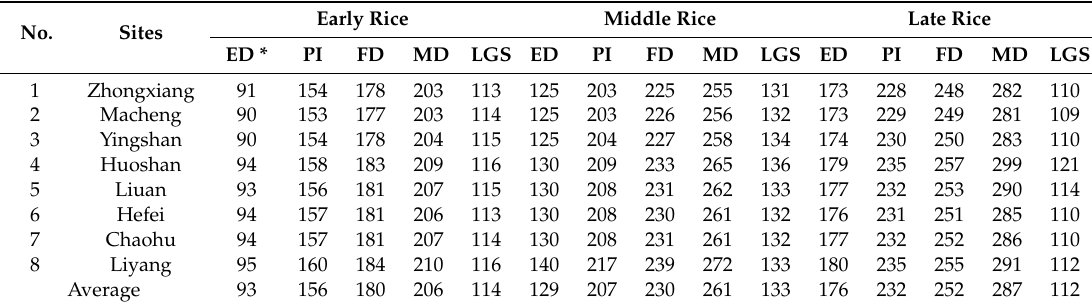
Table 1. Dates (day of the year, DOY) of phenology stages and the length of the growing season (LGS) for early rice, middle rice, and late rice at the selected 8 sites for rice in the study region.